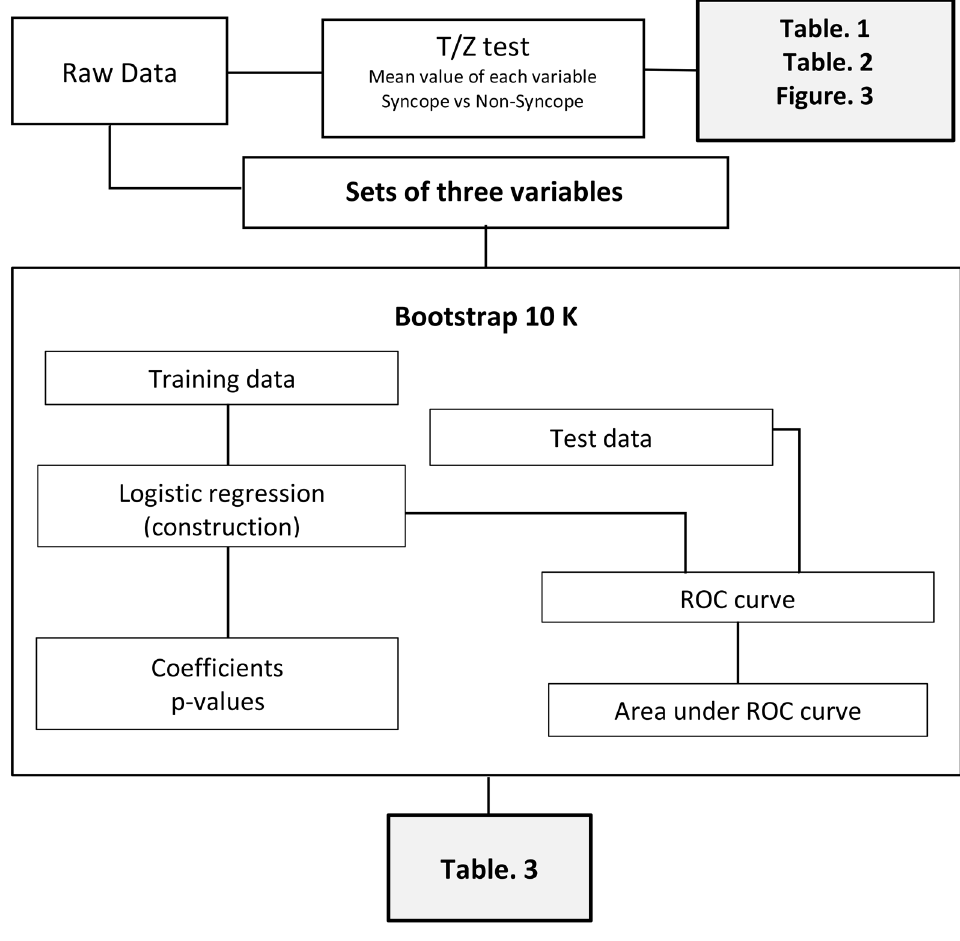
Figure 2. Statistical